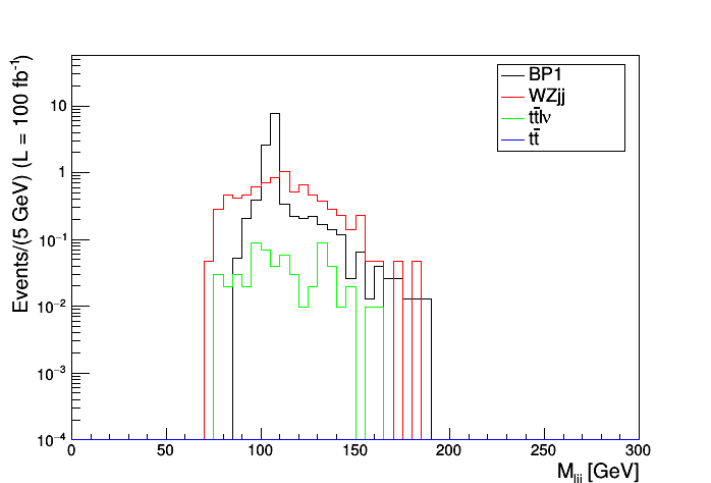
Figure 8 . Distribution in the invariant mass of the two jets and the closest lepton, M ljj , for the benchmark point BP1. Acceptance cuts plus